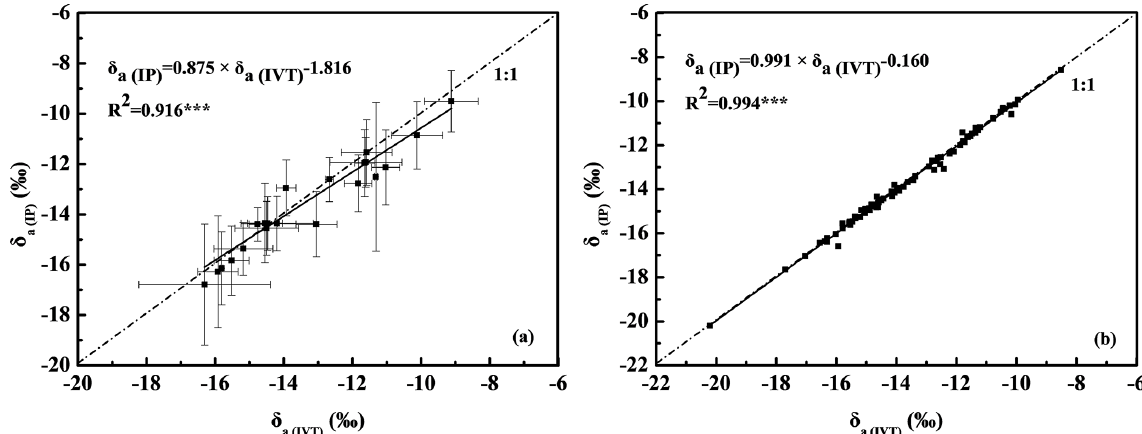
Figure 4. Linear regression between the estimated isotope composition of ambient vapor using the intersection point method ( δ a(IP) ) and the intermediate value theorem method ( δ a(IVT) ) on a daily scale (a) and point-to-point scale (b) ,